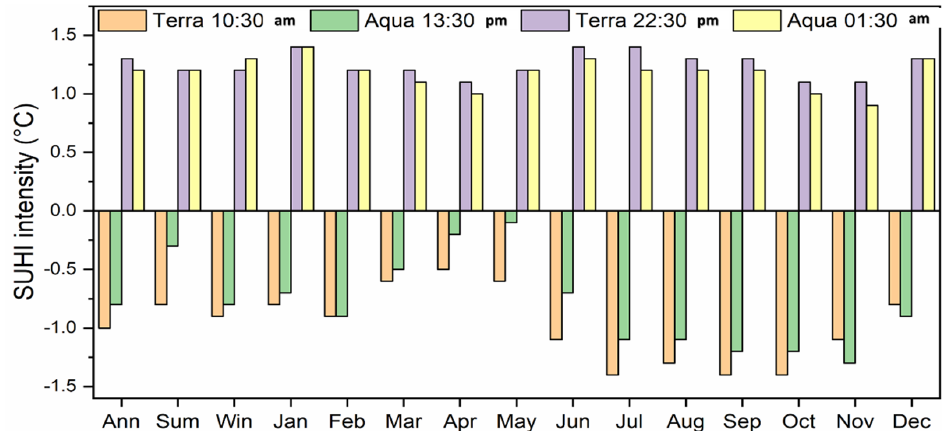
Figure 8. Annual, summer, winter, and monthly variation of mean SUHI intensity (°C) during the period of 2003–2019 at daytime (Terra 10:30 am and Aqua 13:30 pm) and nighttime (Terra 22:30 pm and Aqua 01:30